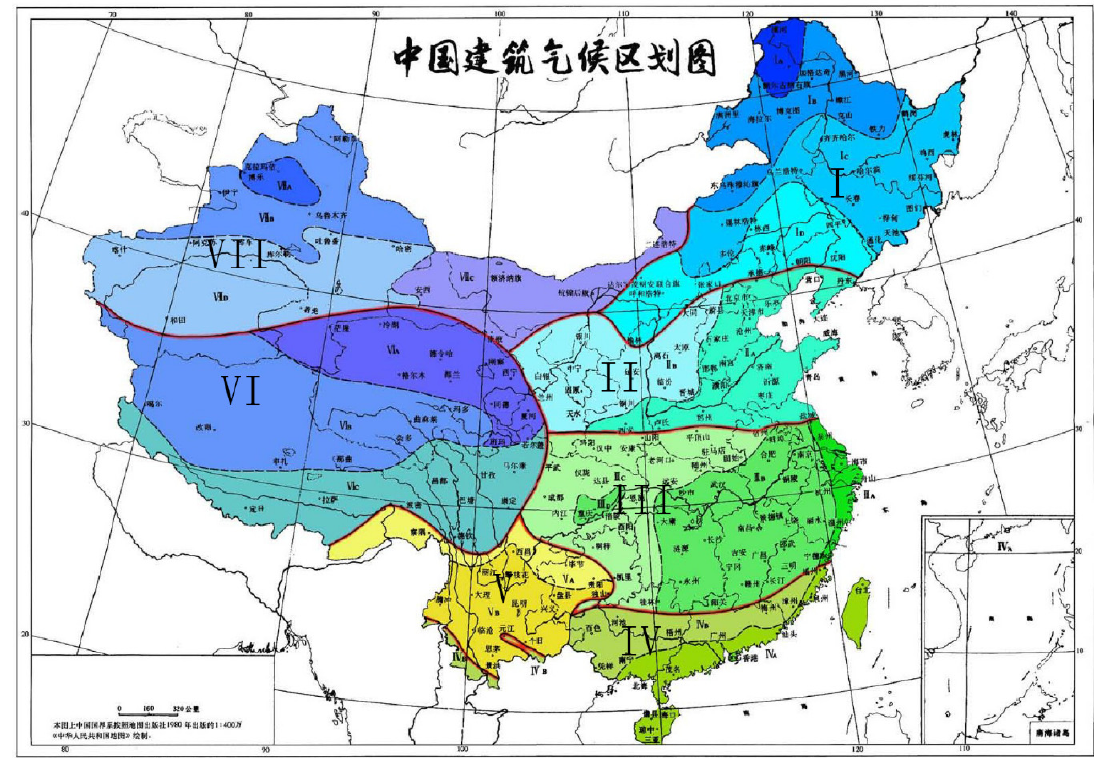
Figure 1. Standard of Climatic Zone Partition of China (resource: www.baidu.com).